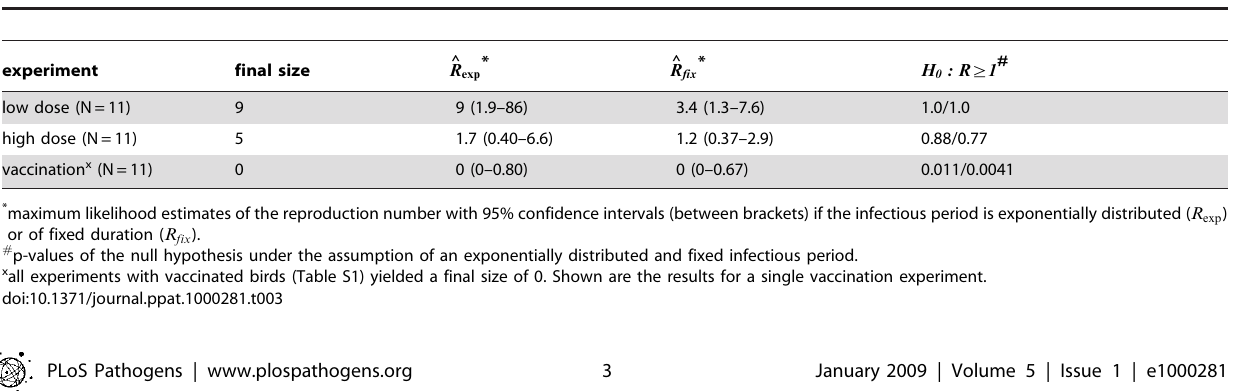
Table 3. Overview of the final size analyses.